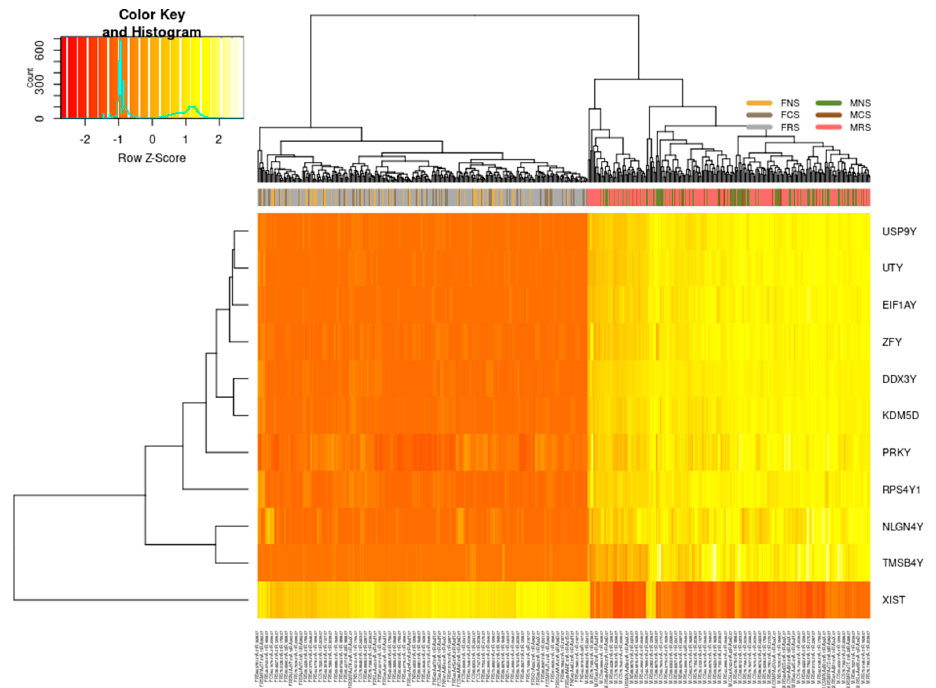
Figure 3. Differentially expressed genes encoded on the sex chromosomes in LUAD cohort. On the right, all 10 genes: USP9Y, UTY, EIF1AY, ZFY, PRKY, NLGN4Y, TMSB4Y, DDX3Y, KDM5D, RPS4Y1 are upregulated in males ( n = 229) regardless of smoking status (MNS, MCS, MRS) or age (range 38–88 years of age), and on the left are downregulated in females ( n = 268), likewise irrespective of smoking status (FNS, FCS, FRS) or age (39–87 years of age).